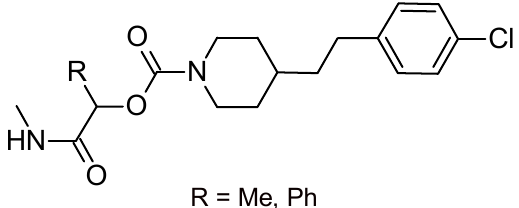
Figure 8. Possible chiral analogs of SA-57 ( 20 ).